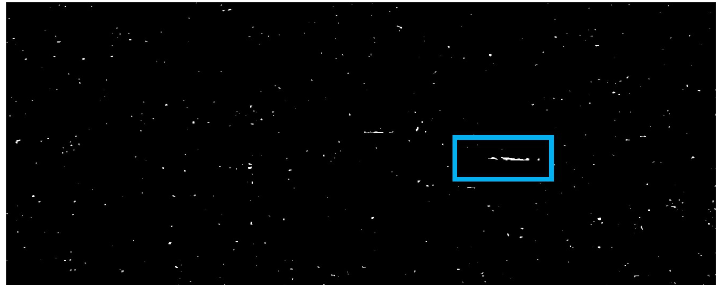
Figure 14. The CFAR detection result of 18th image. The blue box denotes the moving